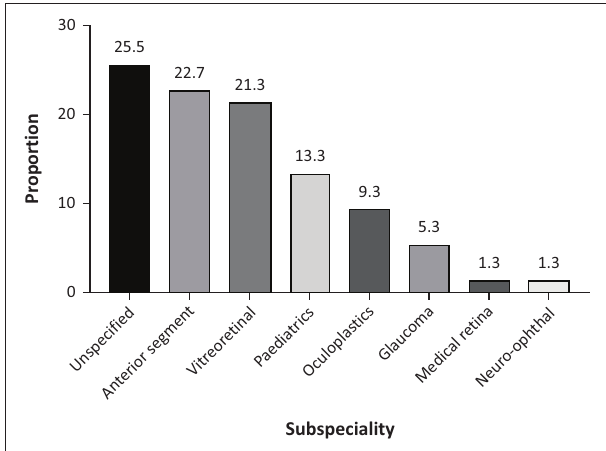
FIGURE 1 : The proportion of 75 subspecialists working in the various subcategories of ophthalmological